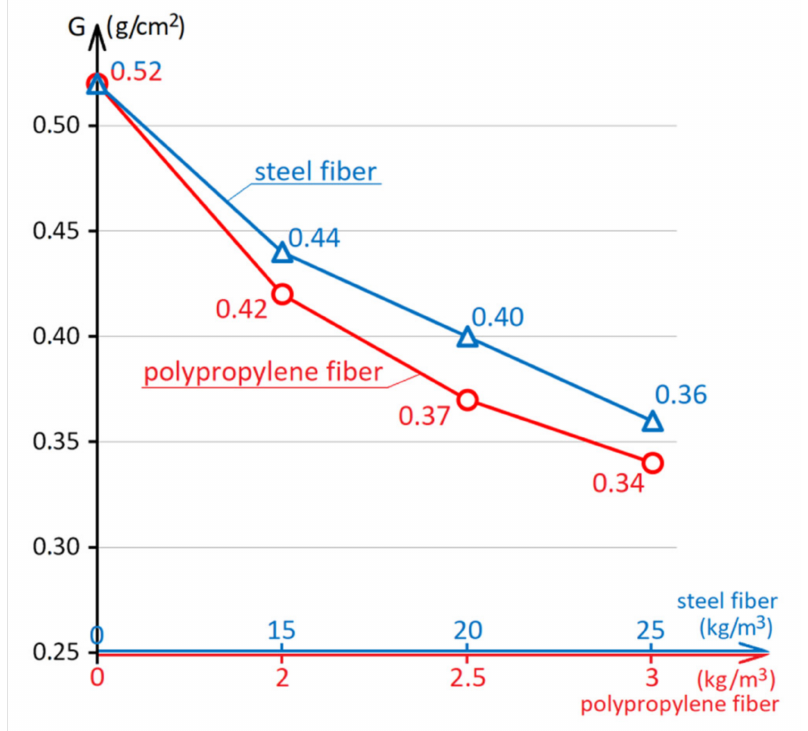
Figure 5. The influence of the steel and polypropylene fibers amount on the concrete abrasion